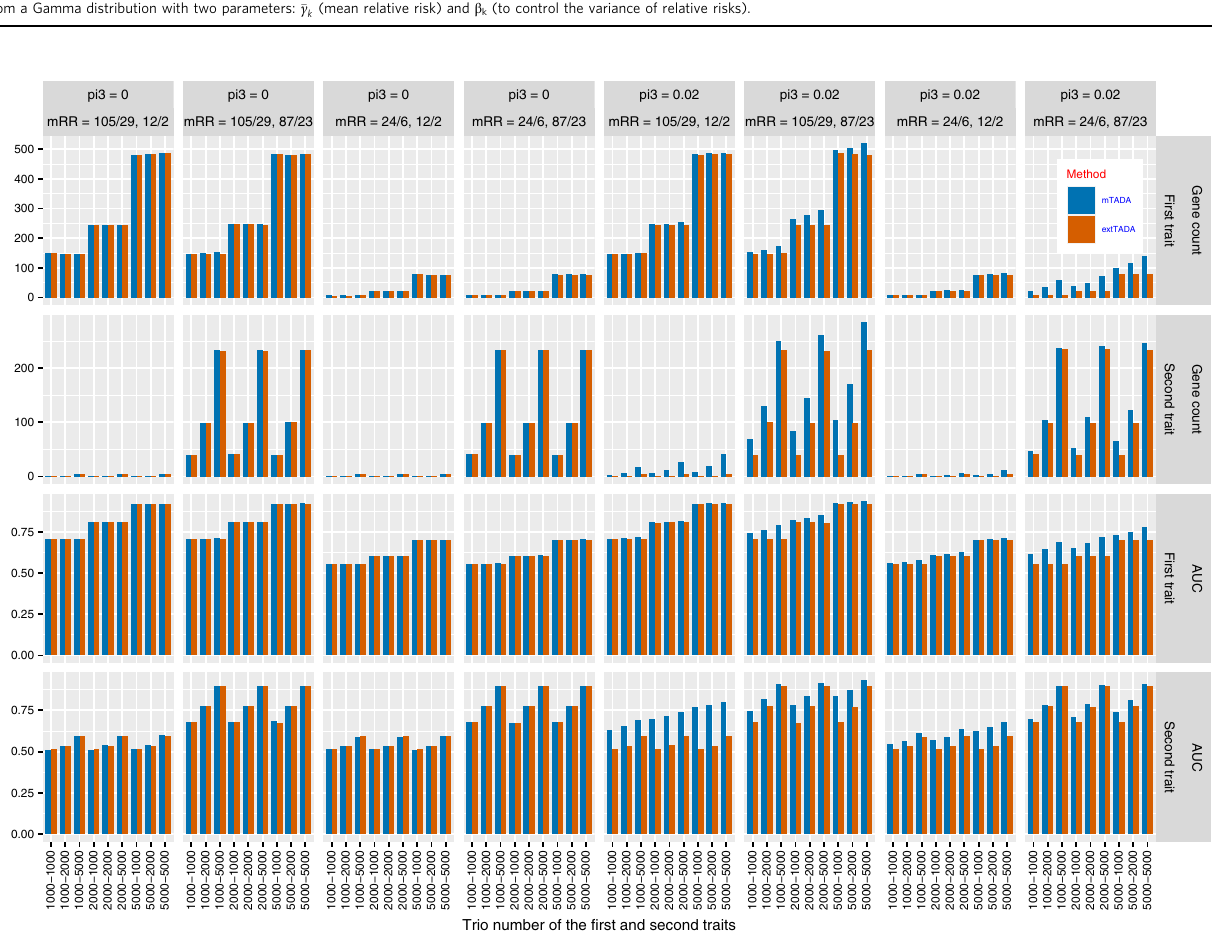
Fig. 2 Comparison results of simulated data for the current multi-trait approach (mTADA) and a previous single-trait approach (extTADA) in single-trait analyses. For each bar, its height shows the average value of 100 simulations. mTADA performs better than extTADA when the proportions of overlapping risk genes (pi3) are larger than zero. The top two lines describe gene counts (posterior probability >0.8, while the two bottom lines show area under the Receiver Operating Characteristic (ROC) curves (AUCs). mRR describes mean relative risks and the trio number along the bottom describes the sample sizes. These results are for two variant categories. For example, “ mRR = 105/29, 12/2 ” describes the mRRs of the fi rst trait as 105 and 29, and the mRRs of the second trait as 12 and